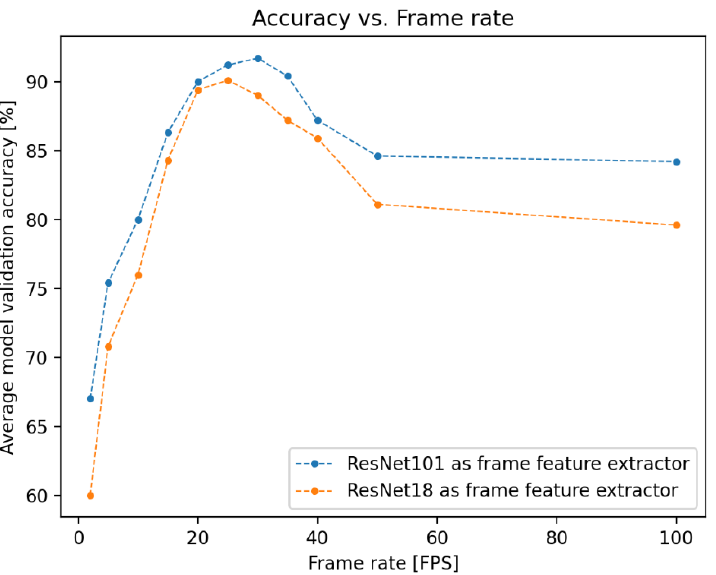
Figure 1. Accuracy vs. frame rate for the flow regime classifier (FlowNet). Depicted here are the results of the hyperparameter searches run during the training of the networks used for offline (using ResNet101) and online (using ResNet18) testing. These results are generated with offline data from the FastCam; as such, performance is expected to degrade in online testing, where data generated by the ArduCam is used.